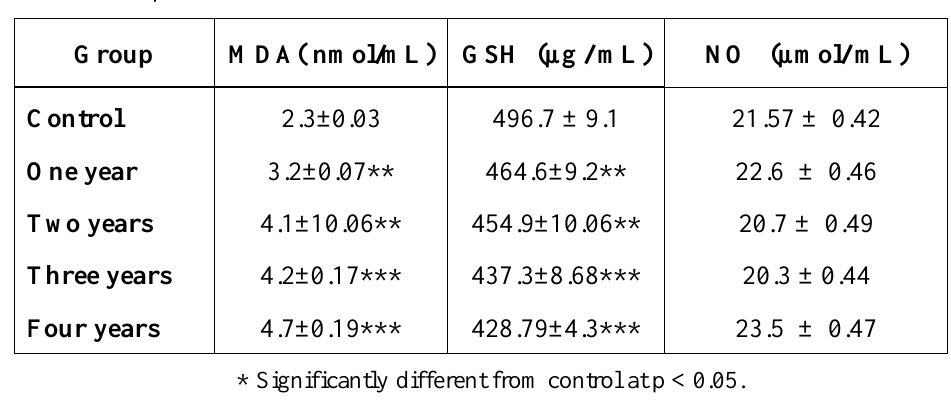
Table 3: Serum lipid peroxide (MDA) erythrocytic GSH and plasma nitrite levels (NO) in DMPA users after 1– 4 years of administration, compared to control. Values are represented as M ± SE